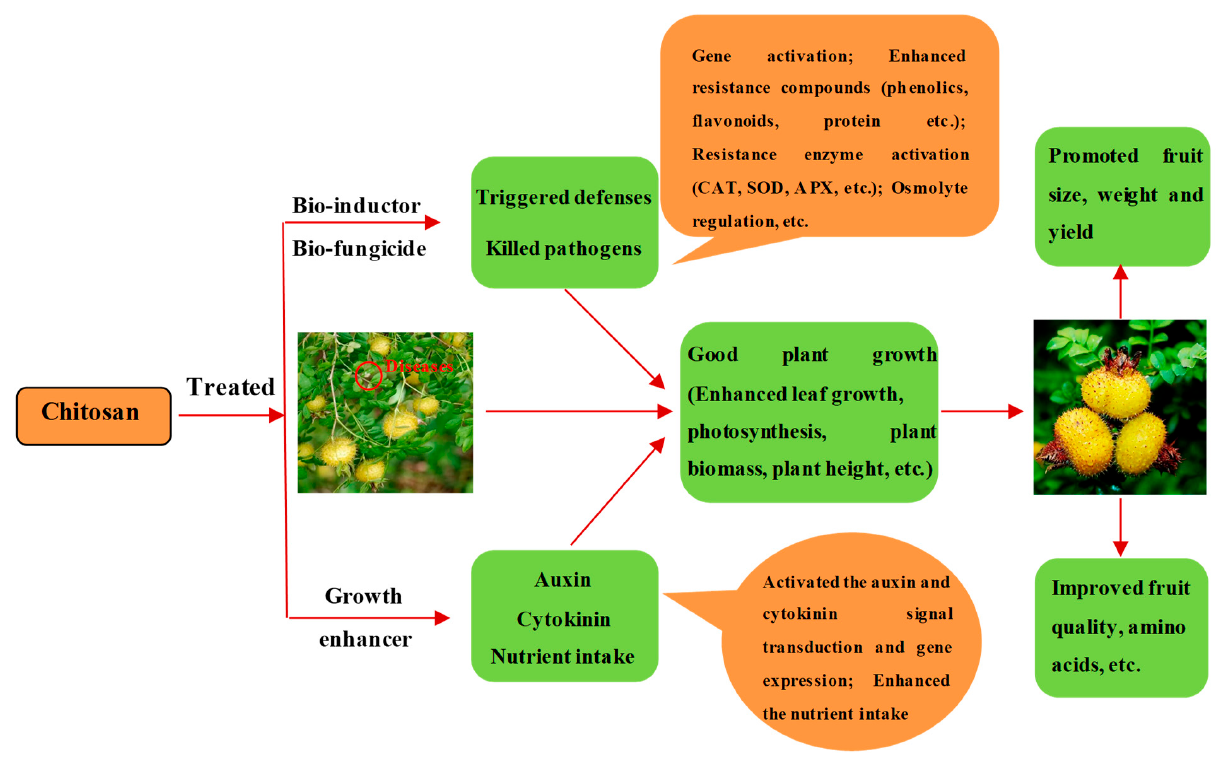
Figure 1. The putative mechanisms of chitosan-mediated plant growth regulation.